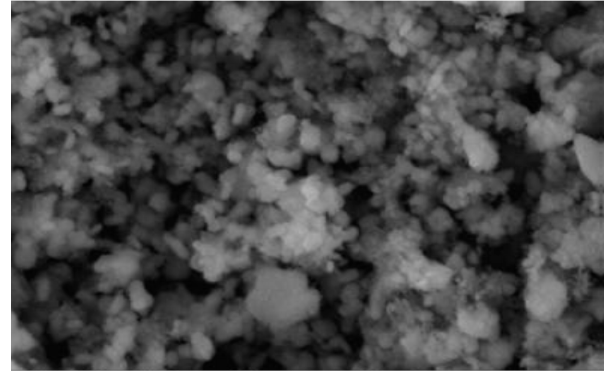
Figure 4. SEM result of the HAP catalyst.